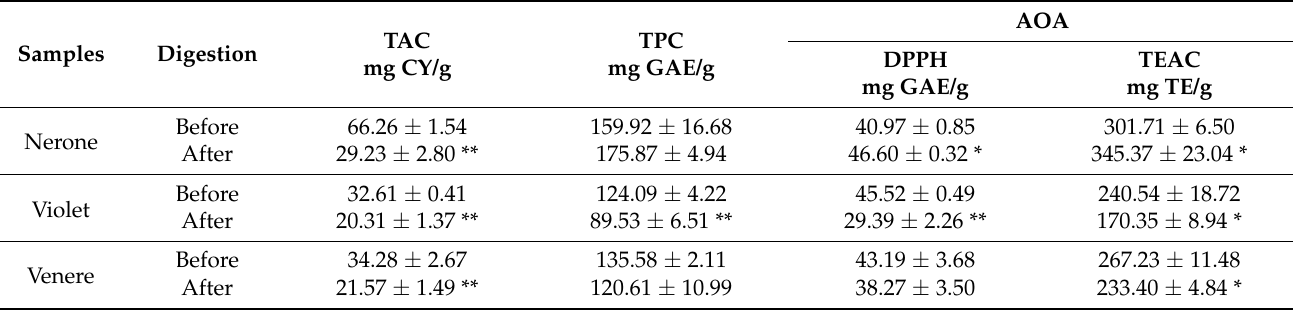
Table 1. Characterization of rice extracts in terms of Total Phenolic Content (TPC), Total Anthocyanin Content (TAC), and Antioxidant Capacity (AOA). Results (mean ± SD, n = 3) are expressed as mg equivalent of gallic acid (GAE)/g, mg equivalent of cyanidin-3- O -glucoside (CY)/g or mg trolox equivalent